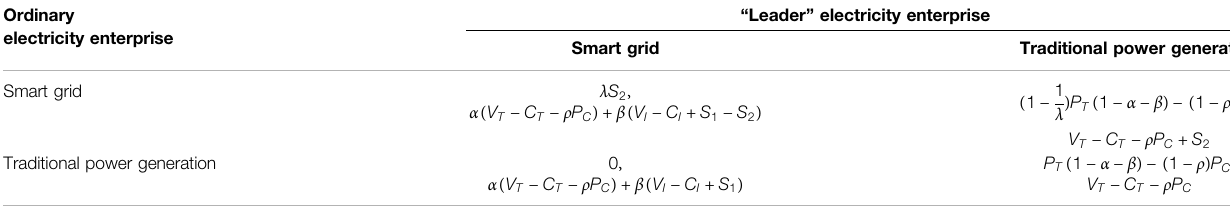
“ Leader ” electricity enterprise Smart grid Traditional power generation